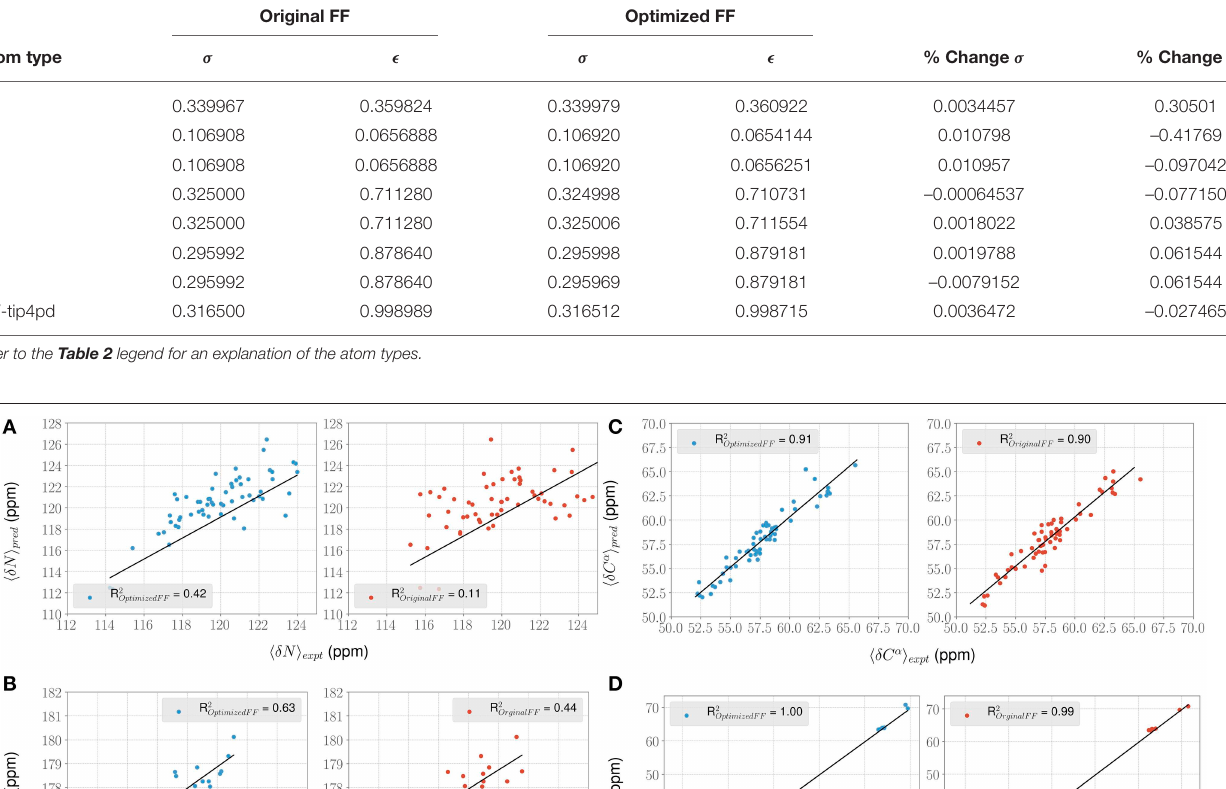
TABLE 4 | Original and optimized Lennard-Jones parameters for PaaA2.